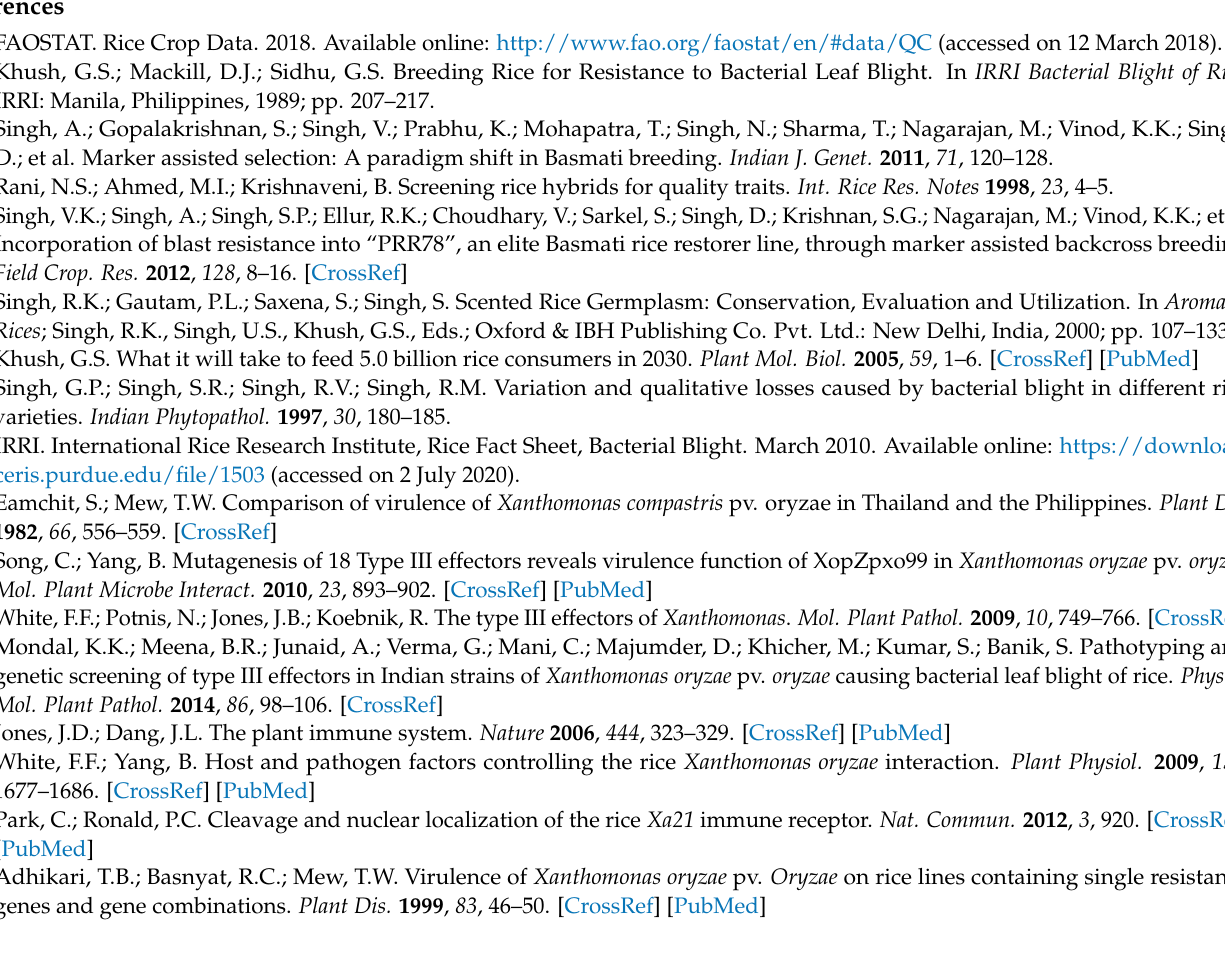
(b) Panicle size of NILs and parents. (c) Grain size of parents and NILs. Supplementary Table S1. Similarity matrix of parental lines taken for genetic diversity analysis. Supplementary Table S2. A list of polymorphic SSR markers between parents HUR 917 and IRBB66. Supplementary Table S3. Brief summary of selection differential and bacterial blight disease index in BC and advanced segregating generations. Supplementary Table S4. RP genome recovery in BC 2 F 2 generation. Supplementary Table S5. X 2 analysis for aroma and palatability in RP and improved lines (BC 2 F 4 ) based on panel test. Supplementary Table S6. Performance of parents and BC2F4 derivatives of HUR 917/IRBB66 for 15 morpho-agronomical traits disease severity, AUDPC value and genome